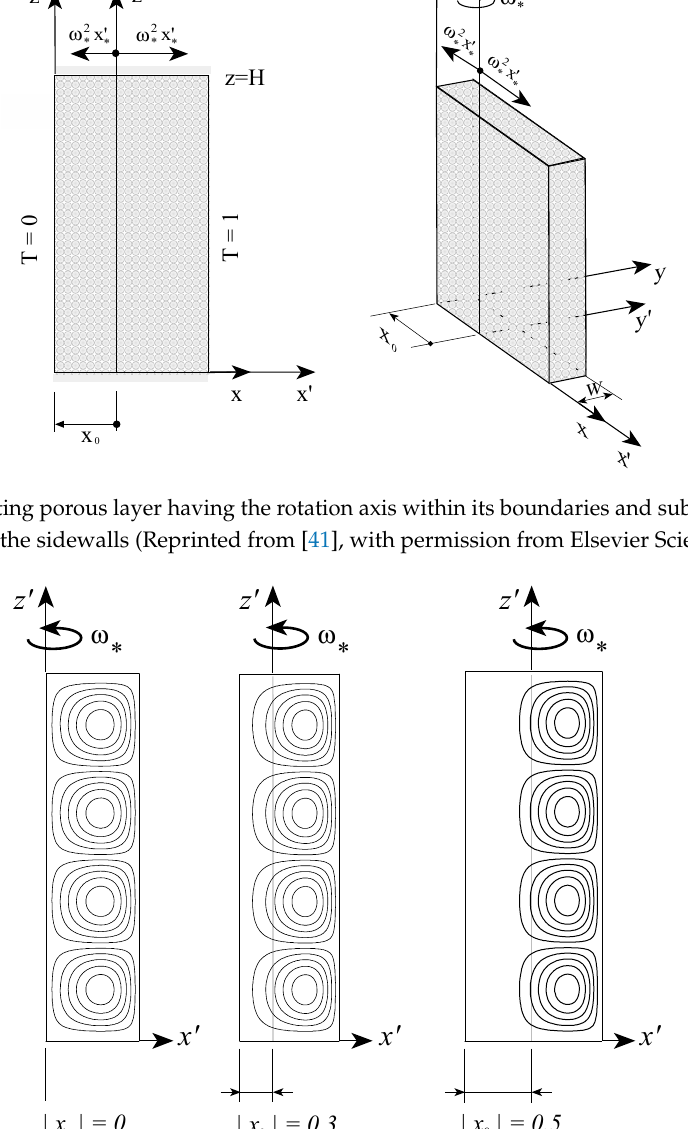
Figure 10. The convective flow field at marginal stability for two different values of x 0 ; 10 streamlines equally divided between ψ min and ψ max . ( a ) streamlines for the axis of rotation located at x 0 = 0.6 ; ( b ) streamlines for the axis of rotation located at x 0 = 0.7 ; (Reprinted from [41], with permission from Elsevier Science Ltd.)